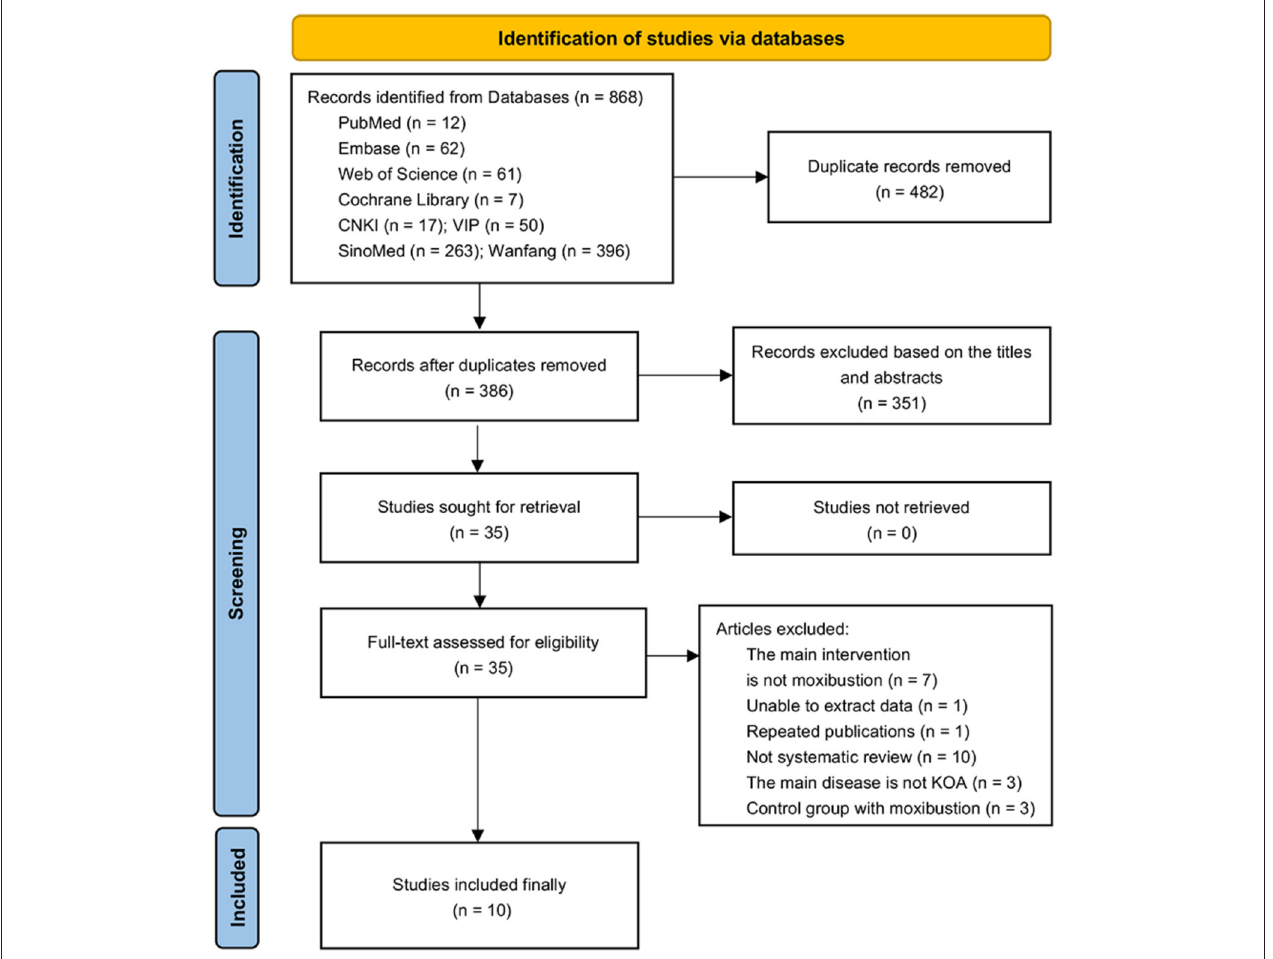
FIGURE 1 | Flow chart of study